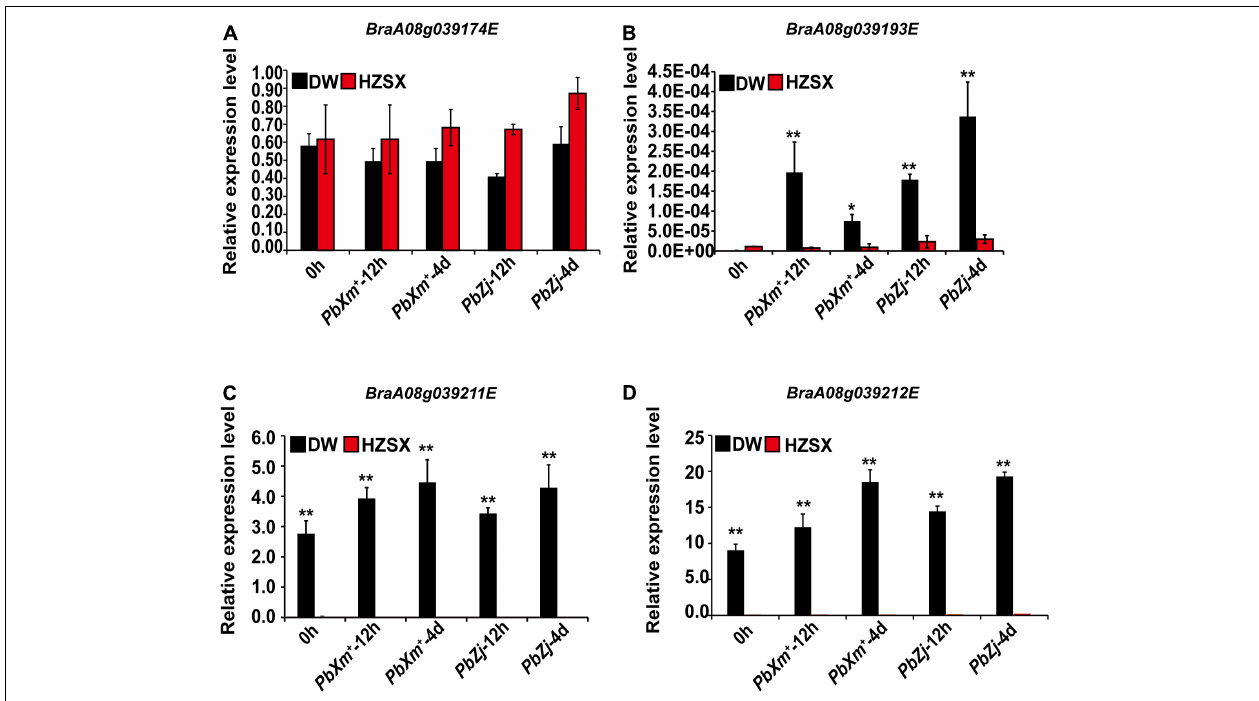
FIGURE 5 | Relative expression of candidate CR genes between DW (black) and HZSX (red) before and after inoculation of PbXm + and PbZj isolates. (A–D) Relative expression of homologs of BraA08g039174E, BraA08g039193E , BraA08g039211E , and BraA08g039212E , respectively. ** represents p ≤ 0.01 by Student’s t